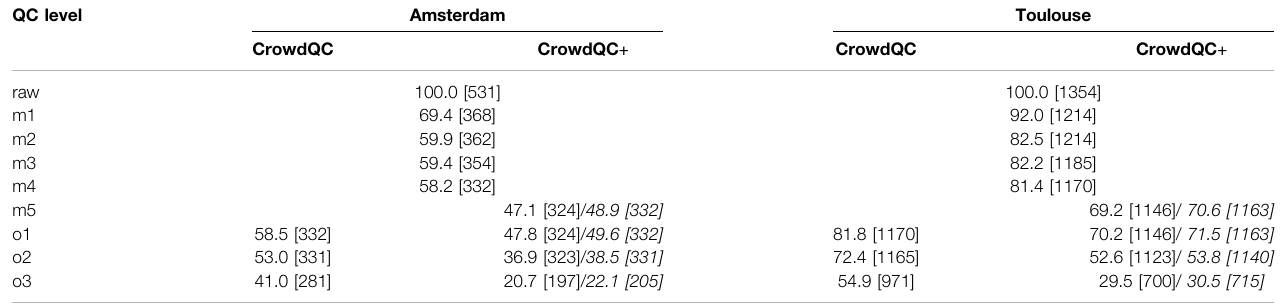
TABLE 3 | Percentage of CWS hourly data availability and number of available CWS (given in brackets) at each QC level in Amsterdam (2019) and Toulouse (2020) after application ofCrowdQC and CrowdQC+ in their respective default settings (cf. Table 2 ). Values for CrowdQC+ for QClevels m5 to o3are given with isolated stations in